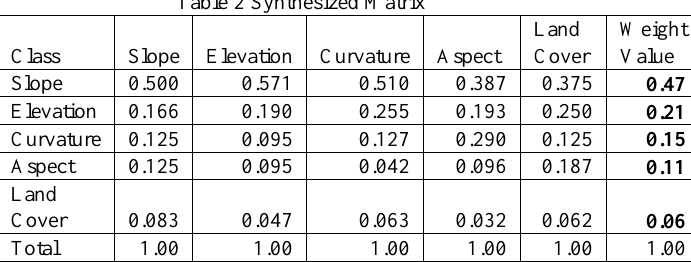
Figure 5 Methodology adapted for Potential avalanche formation zone